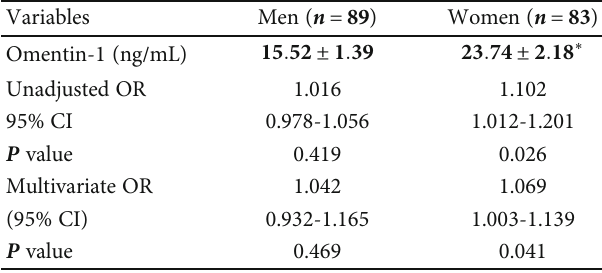
Table 4: Circulating omentin-1 level and its association with the increased presence of osteoporosis in men and women,